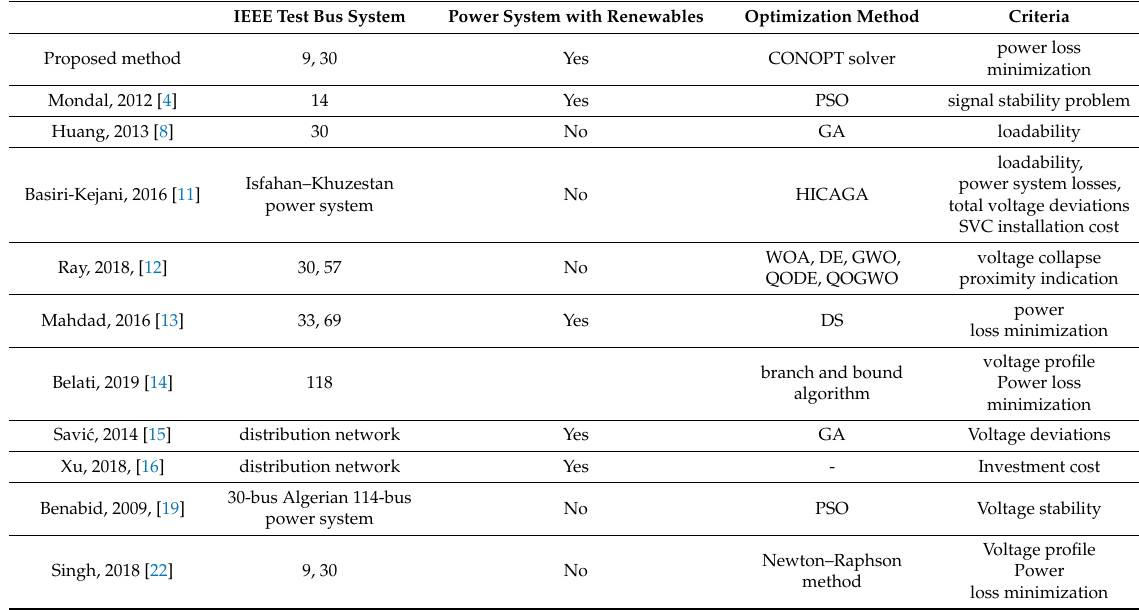
Table 11. Comparison of di ff erent approaches for optimal SVC